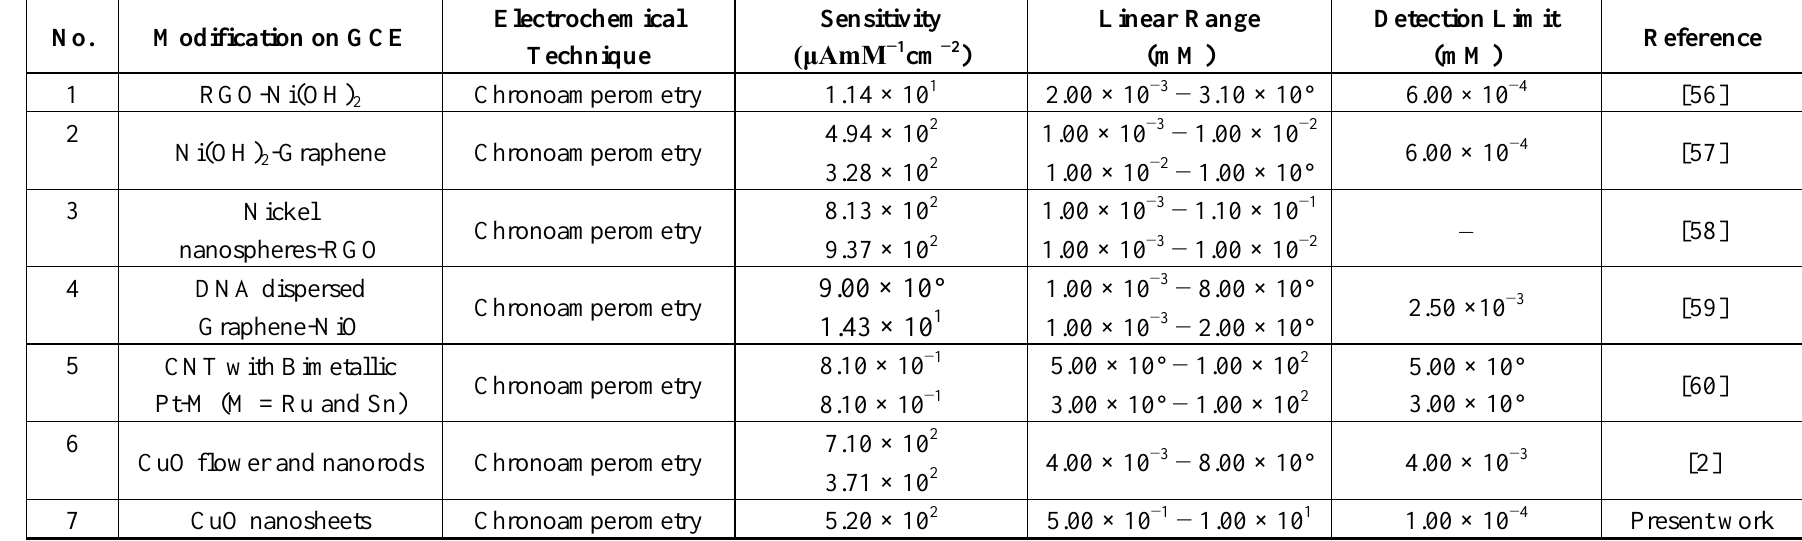
Table 1. Comparison of the present CuO nanosheets sensor electrode with other non-enzymatic glucose